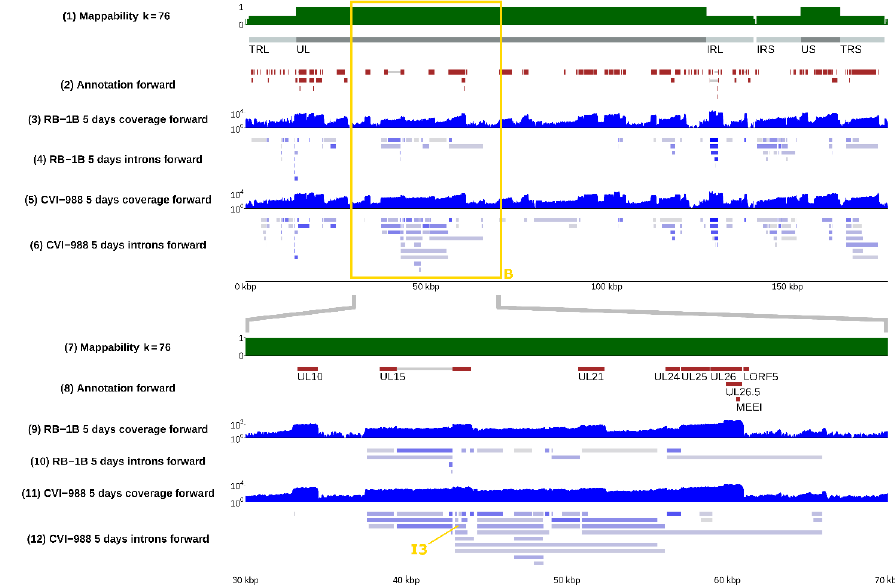
Figure 3. The landscape of alternative splicing in the unique long region of MDV. Top panel : positive strand of the whole MDV genome; bottom panel : the region between positions 30 and 70 kb. The bottom panel is a magnified version of the content of the yellow frame B present in the top panel and in Figure 1. Although many annotated and unannotated introns were present along this area in